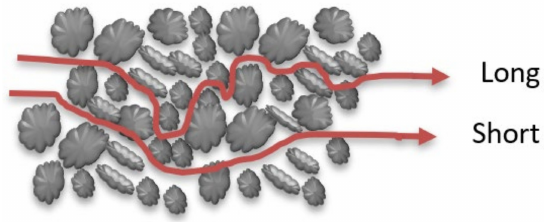
Figure 4. Mechanical dispersion due to path length. (c) Tylor dispersion